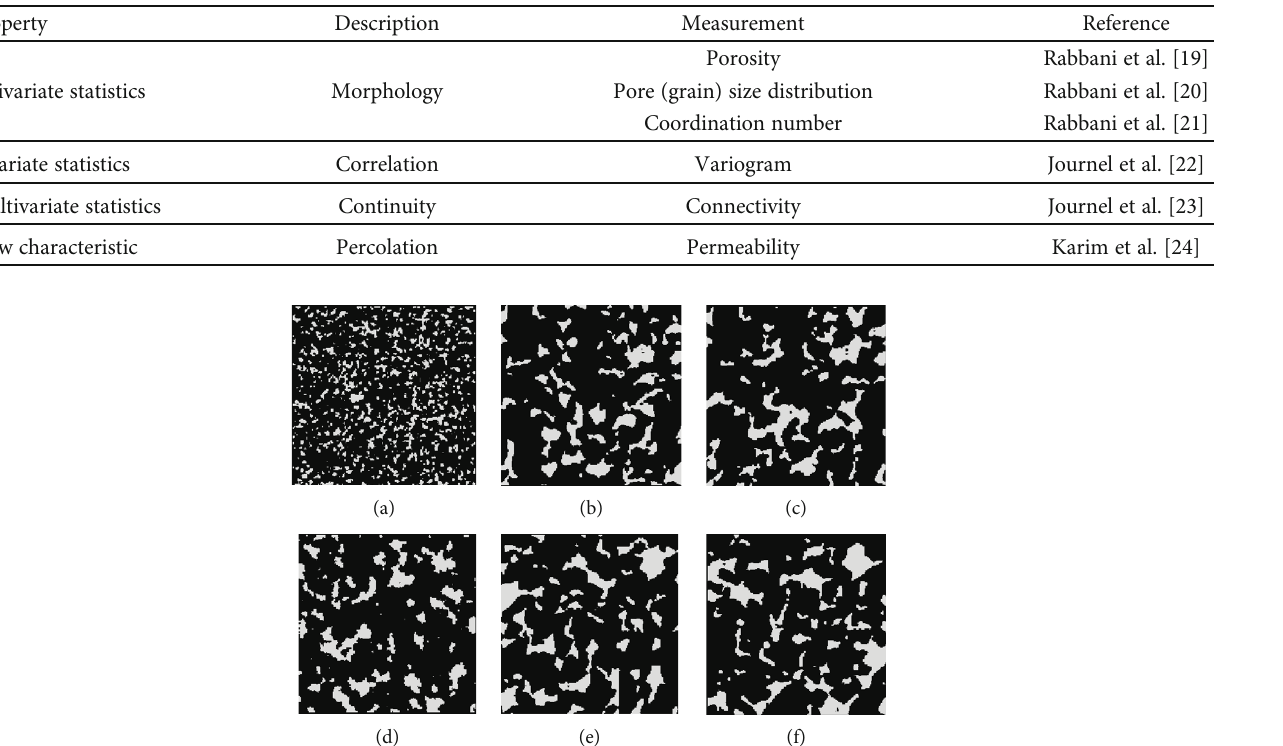
Table 1: Measurements used for simulation results.